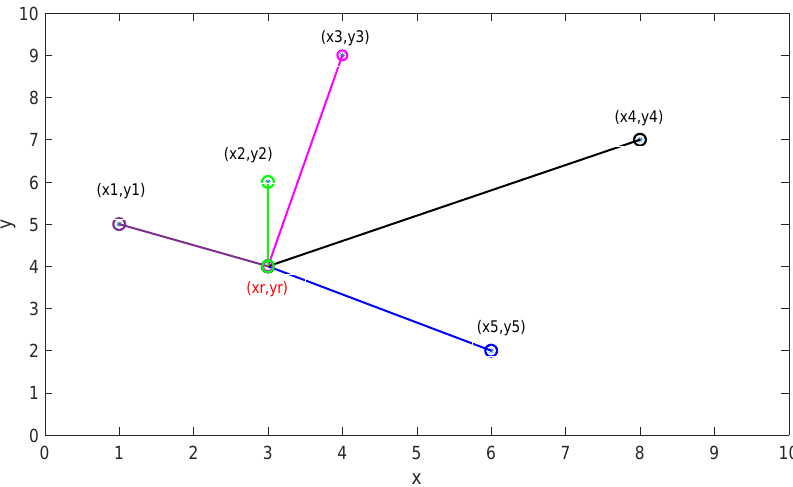
Figure 5. An example application of the BFCP